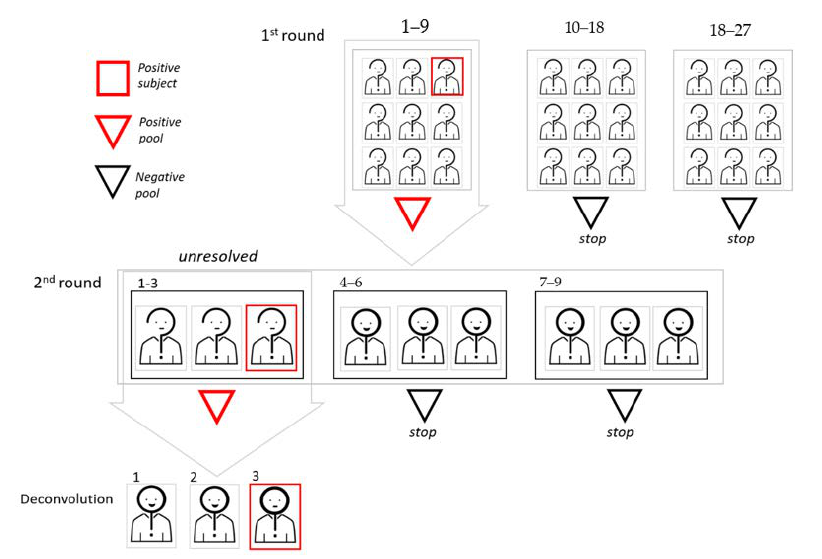
Figure 2. Graphic representation of the two-dimensional (2D) pooling approach. In this example, the cohort dimension is 27, and the first round pool size is 9. Since two pools result as negative in the first round, 12 subjects can be excluded. Sample aliquots from the nine subjects of the pool that tested as positive are used for a 1D pooling approach, where the pool size is 3.